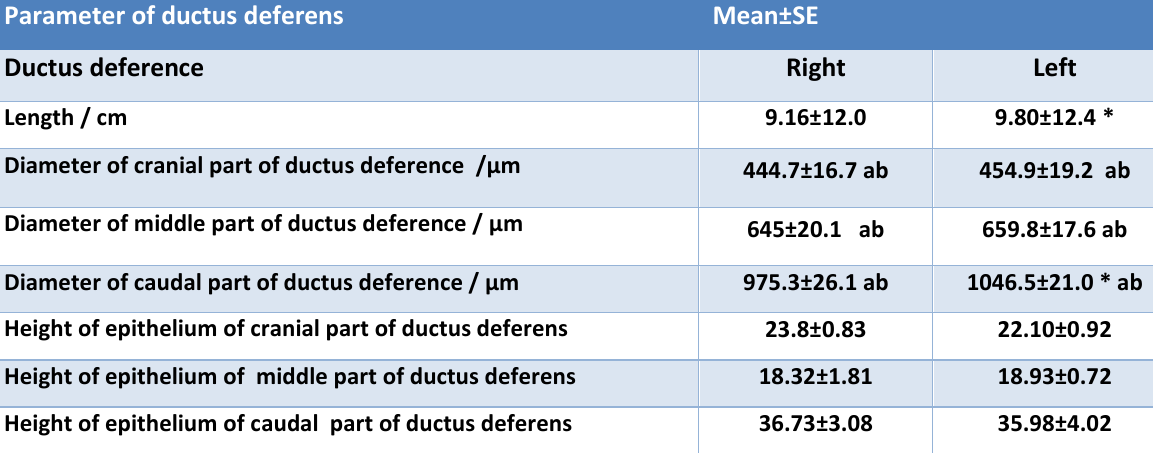
Diameter of caudal part of ductus deference / µm Height of epithelium of cranial part of ductus deferens